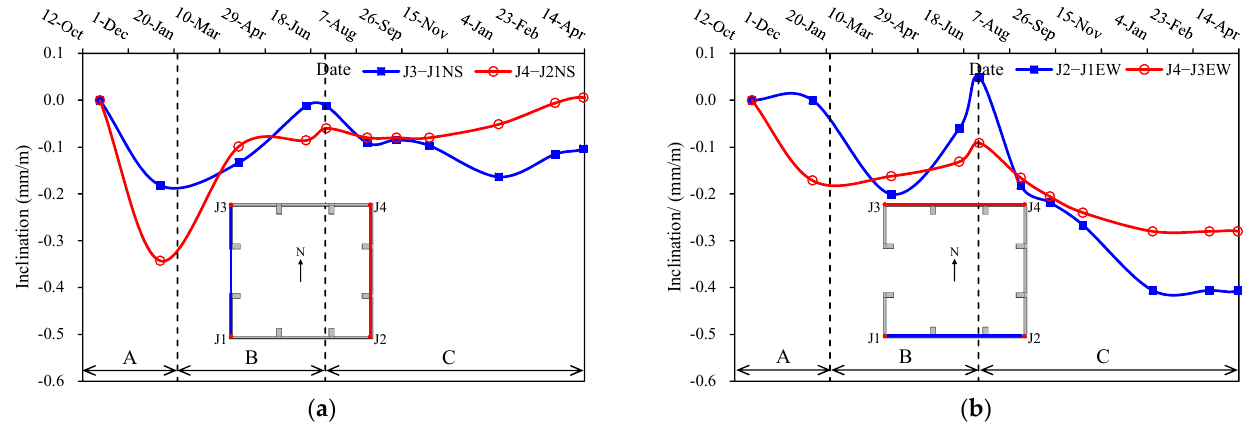
Figure 5. High-precision levels’ monitoring results of shaft tower foundation inclination in DHS process. ( a ) Inclination in the north and south; ( b ) inclination in the east and west.